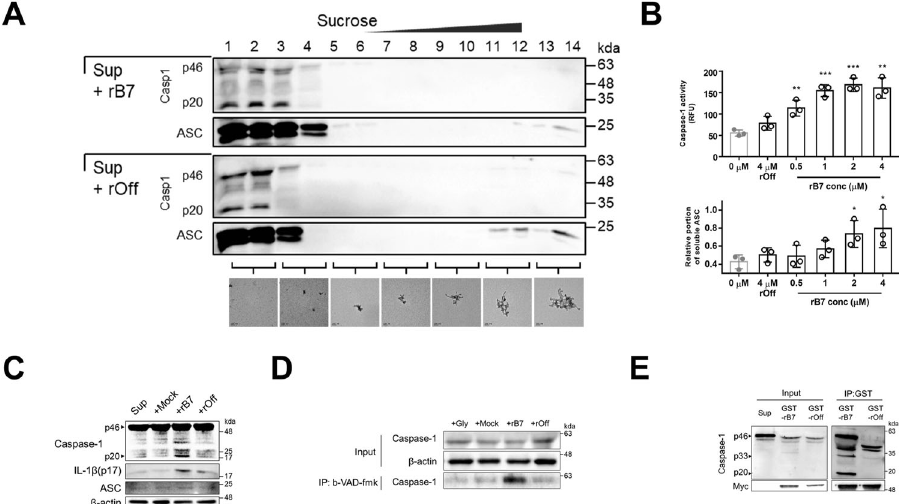
Fig. 5 Linkage between the processing of premature caspase-1 and oligomeric states of extracellular ASC specks. A Analysis of tethered caspase-1 and ASC in each fraction obtained through sucrose-gradient (5 – 45%) ultracentrifugation of endogenous ASC specks. Cell-free supernatants from stimulated THP-1 cells containing ASC specks were incubated with 5 μ M of rB7 or rOff for 1 h, followed by sucrose-gradient ultracentrifugation (167,000× g , 10 min), and the levels of caspase-1 (Casp1) and ASC in each fraction were analyzed using western blot (top panel). Negative stain EM images of ASC specks in each fraction were obtained through sucrose-gradient ultracentrifugation (bottom panel) at the same condition as in the top panel except for the use of recombinant ASC specks. The bars indicate 100 nm. Data were representative of three independent experiments. B . Caspase-1 activation through extracellular ASC specks in the presence of varying concentrations of rB7. After various concentrations of rB7 or rOff were added to the cell media, LPS/nigericin was used to stimulate THP-1. A fl uorogenic substrate (z- YVAD-AFC) was added immediately after stimulation, and caspase-1 activity was assayed by measuring the change in the fl uorescence intensity. Soluble ASC in the cell-free supernatants was separated through centrifugation (18,000× g , 10 min), and the amounts of ASC were determined by band intensity on western blot. The data represent the means ± SDs from triplicate experiments. *** p < 0.001, ** p < 0.01, and * p < 0.05 compared with the control (two-tailed unpaired Student ’ s t -test). C Immunoblot analysis of processed caspase-1 species and mature IL-1 β when cell-free supernatants from stimulated THP-1 cells were incubated with 5 μ M of rB7, rOff, or DPBS (Mock) for 1 h. Data were representative of three independent experiments. D Immunoblot analysis of active caspase-1 labeled with biotin-VAD-fmk in the presence of rB7. 3 μ M of rB7 or rOff were added to the extracellular space of THP-1 cells as in ( B ). Biotin-VAD-fmk was added 30 min before stimulation with nigericin. The labeled caspase-1 was pulled down using streptavidin-conjugated dynabead. The eluted fraction was analyzed using a western blot. “ Gly ” indicates the addition of glycine before stimulation to prevent pyroptotic cell lysis. Data were representative of three independent experiments. E Immunoblot of caspase-1 eluted from co-immunoprecipitation using GST-fused rB7 or rOff in stimulated cell-free supernatants. Myc-tag was fused to the C-terminus of GST-fused rB7 and rOff for detection. Data were representative of three independent 1 and fractions 10 – 14, and the level of caspase-1 CARD -SUMO-FLAG that had co-migrated with highly oligomerized ASC specks was shown to be very low and detected only in fraction 2. In contrast, treatment of ASC specks with rB7 resulted in a drastic decrease in the level of ASC in fractions 10 – 14. At the same time, the ASC levels in fractions 2 – 4, which contain low oligomeric states of ASC